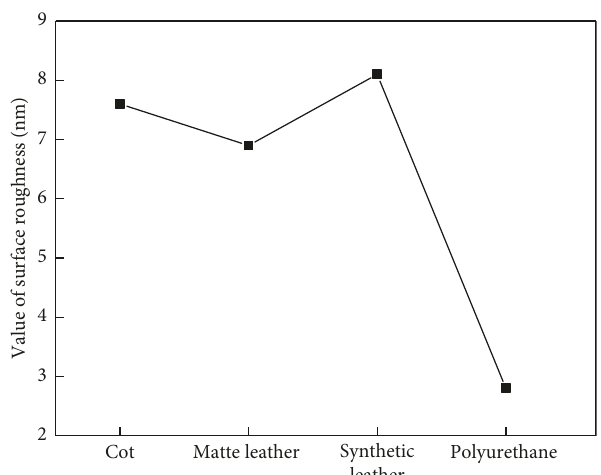
Figure 4: The relationship between the surface roughness and the polishing time.